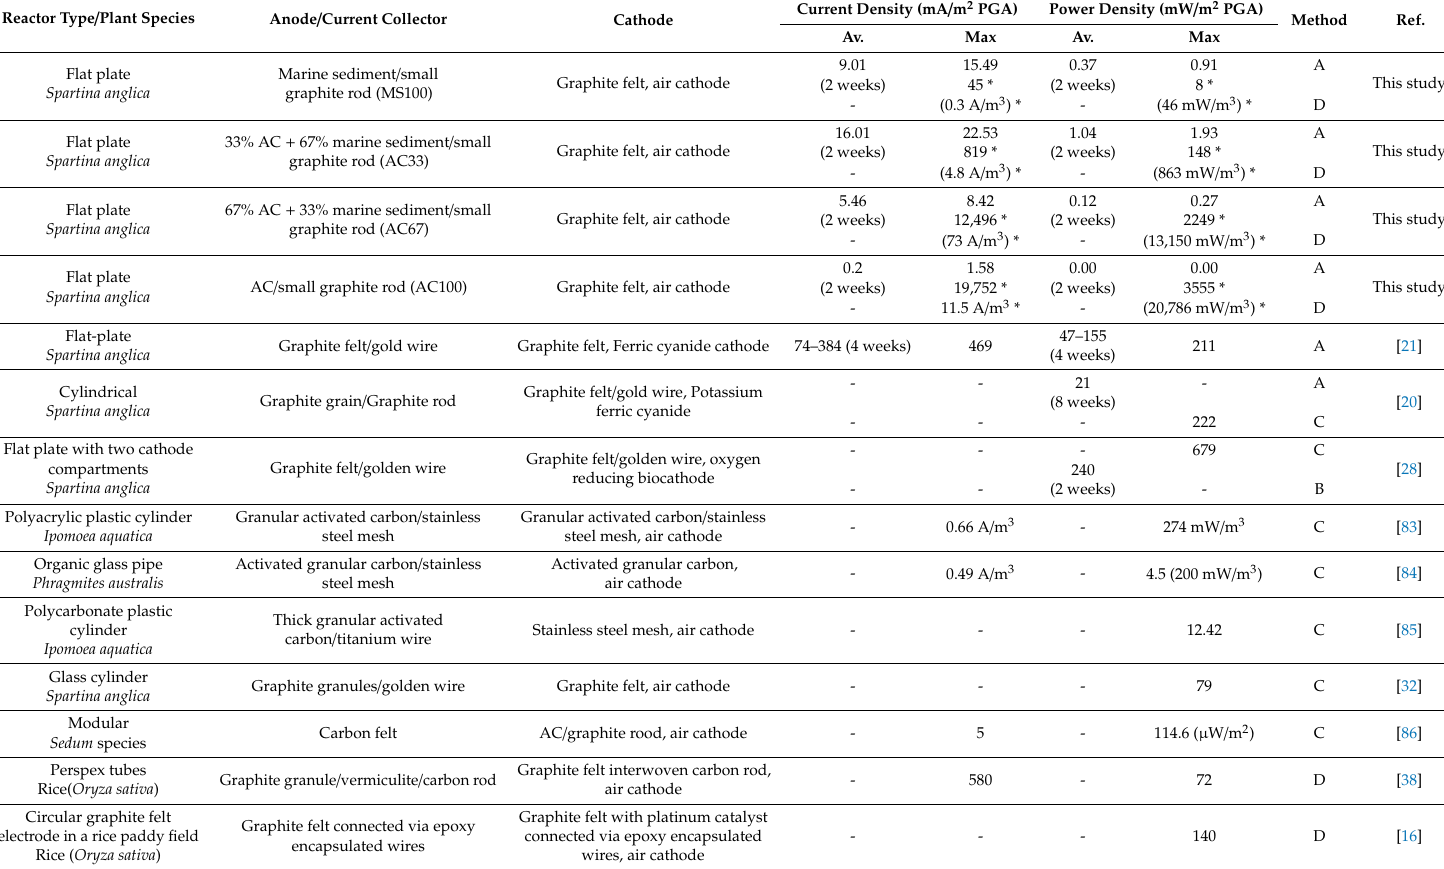
Table 1. Average and maximum current and power densities of several Plant-MFC